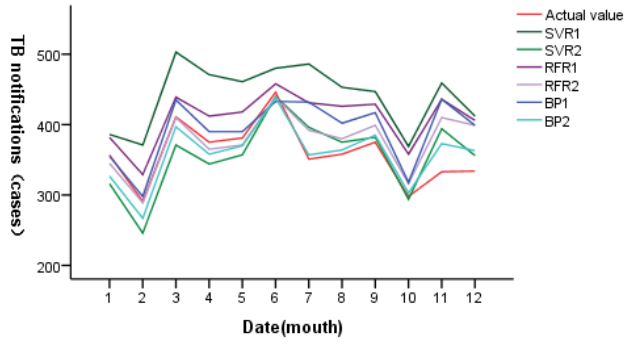
Figure 10. Prediction results of SVR, RFR and BP neural network prediction models (by monthly statistics).